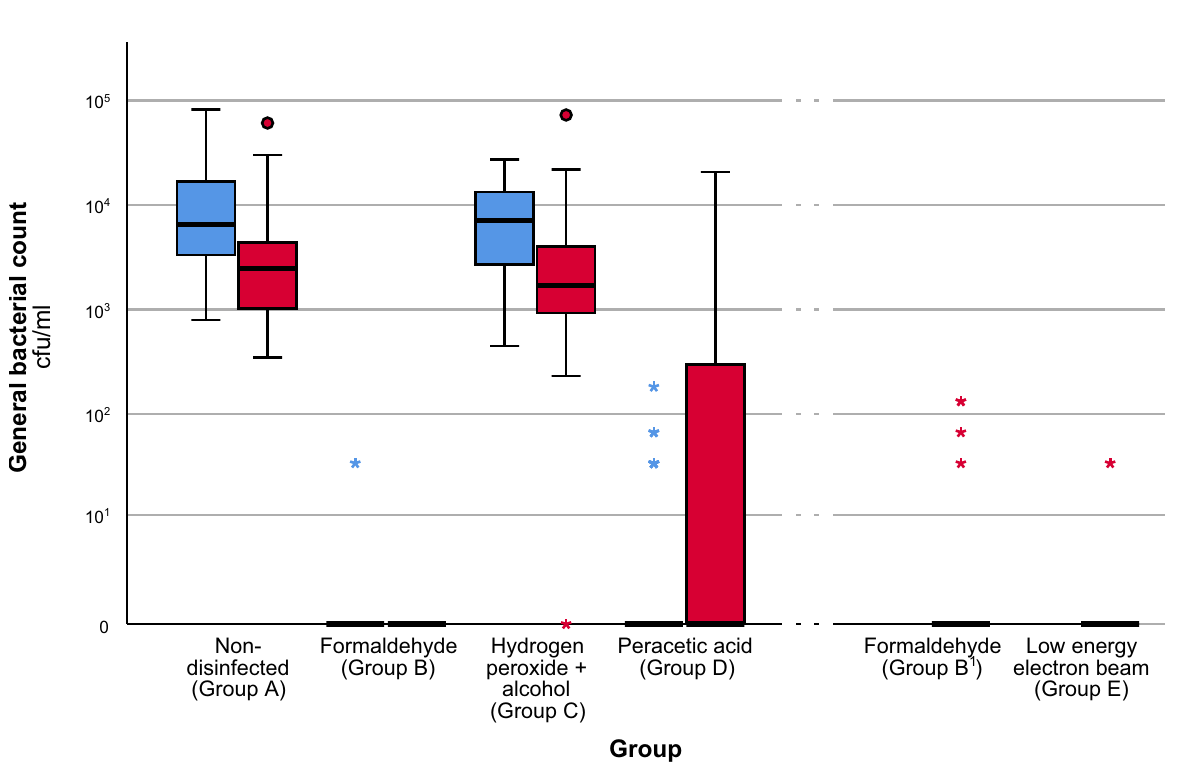
Fig 1. Re-isolation rates of bacteria found on the eggshell with eggshell rinse method from control and disinfection groups. The re-isolation rates are divided by group and flock. The number of eggs tested per group was 100 with n = 50 per flock. Formaldehyde Group B 1 and low energy electron beam (Group E) present a total of 100 samples from only one flock. The box represents the interquartile range, the line the median of the samples, the circle represents a cluster of outlier values, while the asterisk represents a single outlier value. The data is representative for one of the two repetitions (for repetition see S2 Fig.). https://doi.org/10.1371/journal.pone.0283699.g001 MALDI-TOF and 16S rRNA genomic sequencing. The re-isolated bacteria mainly belonged to gram-positive bacteria, specifically the Staphylococcus species as shown in Table 4. The lack of growth in the MacC agar predicted a mostly gram-positive species identification with MALDI-TOF. The samples were selected for the diverse agars but mainly UTI and CNA. In the case of the re-isolation on the formaldehyde and low energy electron beam group, the colonies that presented growth on any of the plates were selected for comparison with other groups.